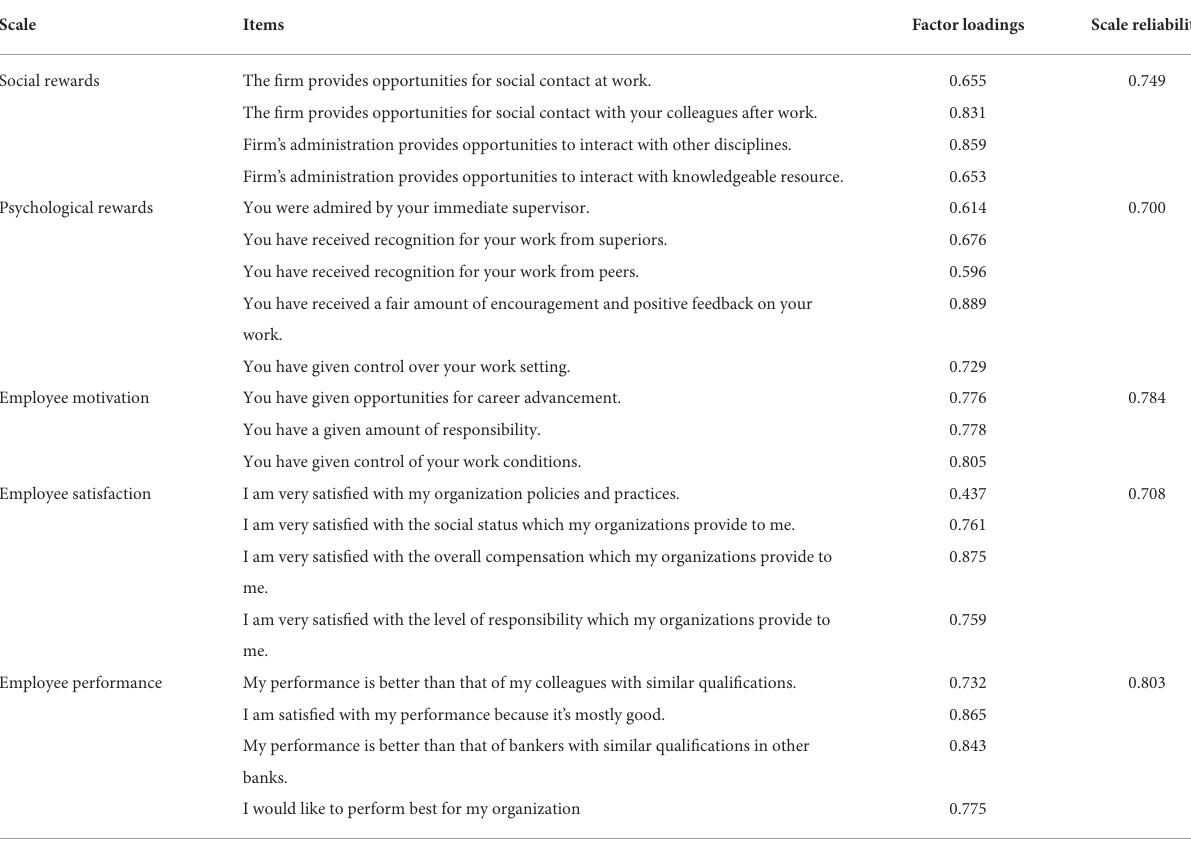
TABLE 3 Pooled confirmatory factor analysis (independent, mediating, and dependent variable). Scale Items